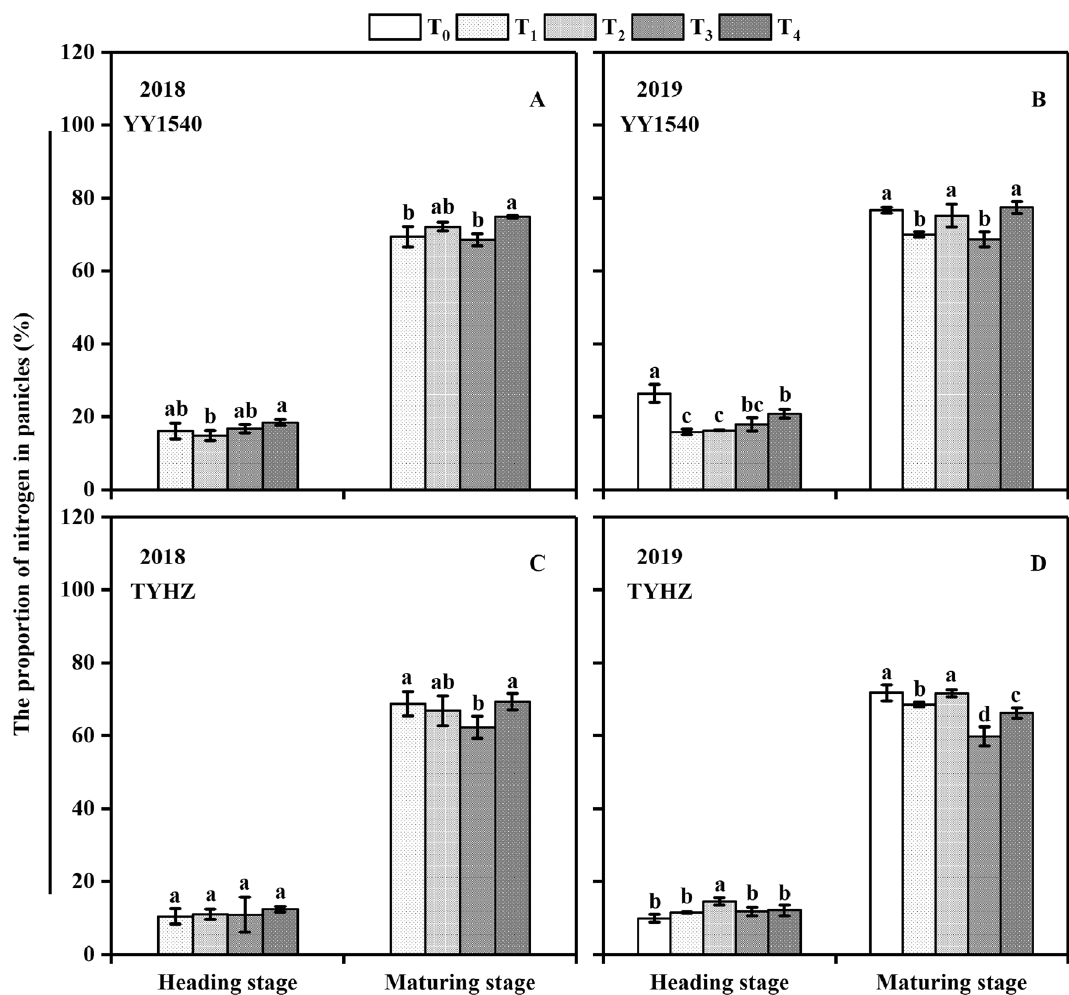
Figure 6. Proportion of nitrogen accumulation in panicles of indica – japonica hybrid rice (‘Yongyou1540’, YY1540) and indica hybrid rice (‘Tianyouhuazhan’, TYHZ) under four nitrogen fertilization treatments. ( A ) YY1540 in 2018; ( B ) YY1540 in 2019; ( C ) TYHZ in 2018; ( D ) TYHZ in 2019. Bars with different lower-case letters are significantly different at the 0.05 probability level among treatments. T 0 no-nitrogen application control, T 1 traditional nitrogen application, T 2 single-dose controlled-release nitrogen application, T 3 70% controlled-release nitrogen as side-deep fertilization with machine transplanting and 30% as topdressing